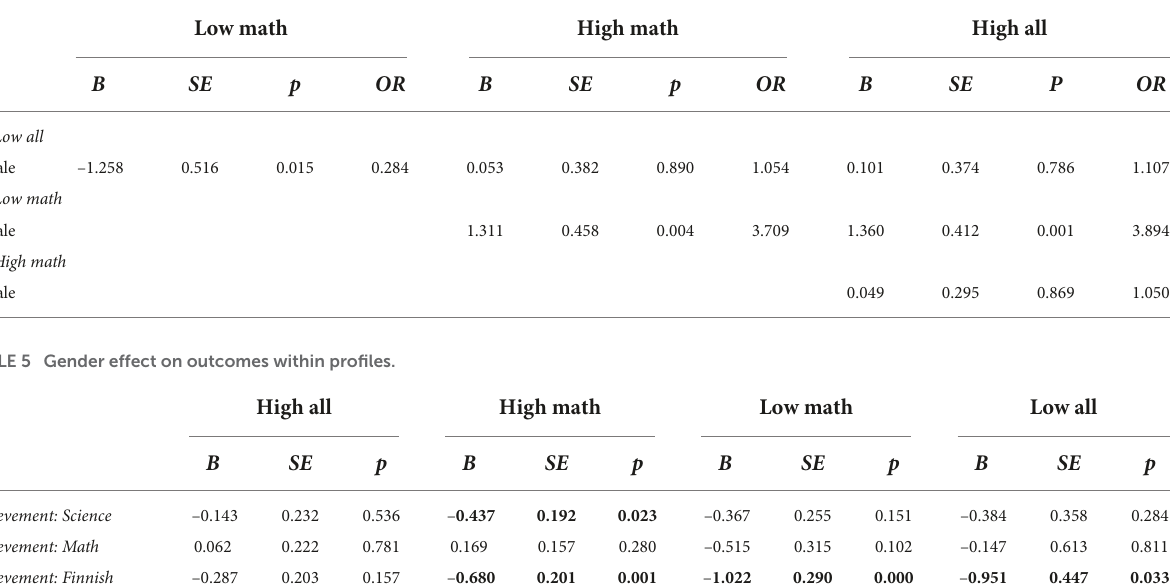
TABLE 4 Gendered difference in profile membership.